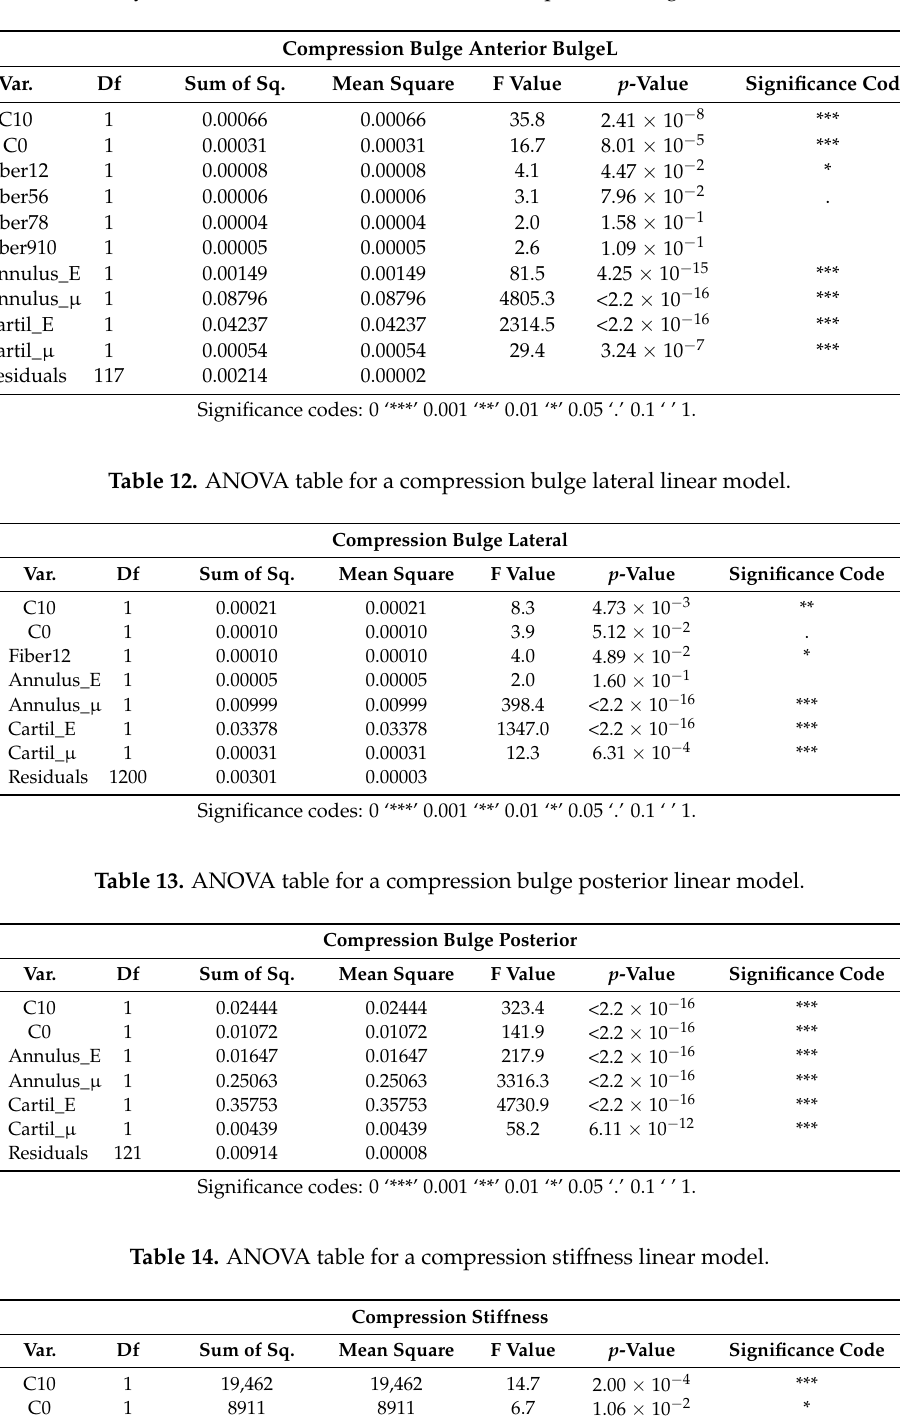
Table 11. Analysis of variance (ANOVA) table for a compression bulge anterior linear model.